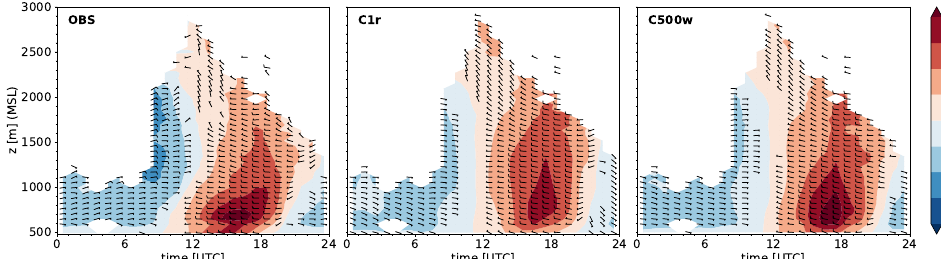
Figure 6. Mean diurnal cycle of the valley wind (vector-averaged) for the valley-wind days in September 2016 from observations and simulations for the location of Sion. Observations are based on a combination of the low-mode wind profiler and the weather station data. The filled contours indicate the along-valley wind speed (m/s) with positive values for up-valley wind, and the barbs denote the wind direction with respect to the valley’s axis. The wind speed is masked if more than 50% of the values are missing and wind barbs are plotted if the wind speed is greater than 2.5